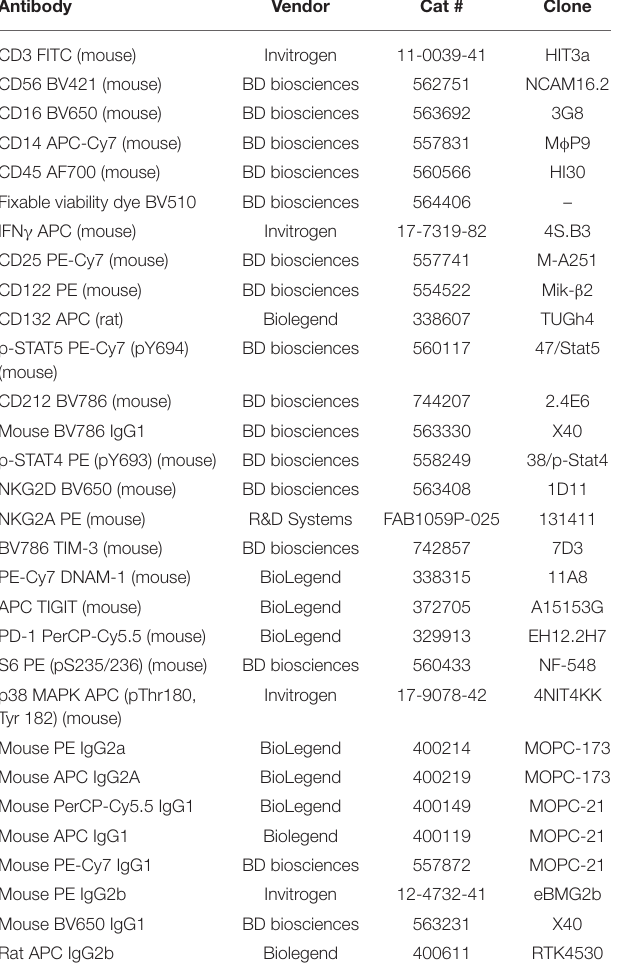
TABLE 1 | Antibodies used in whole blood